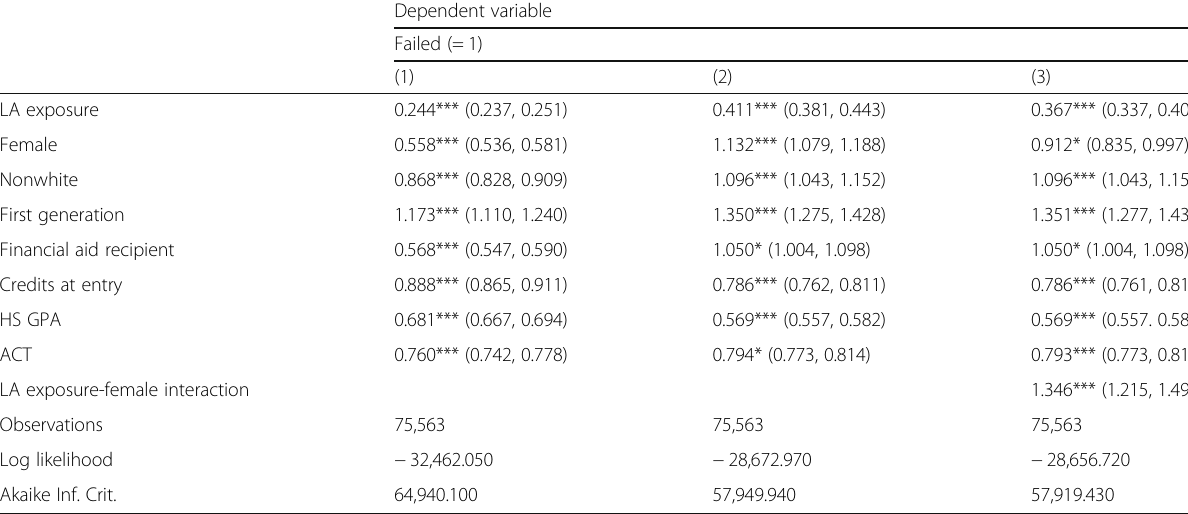
Table 5 Logistic regression estimates in odds ratios with confidence intervals Dependent